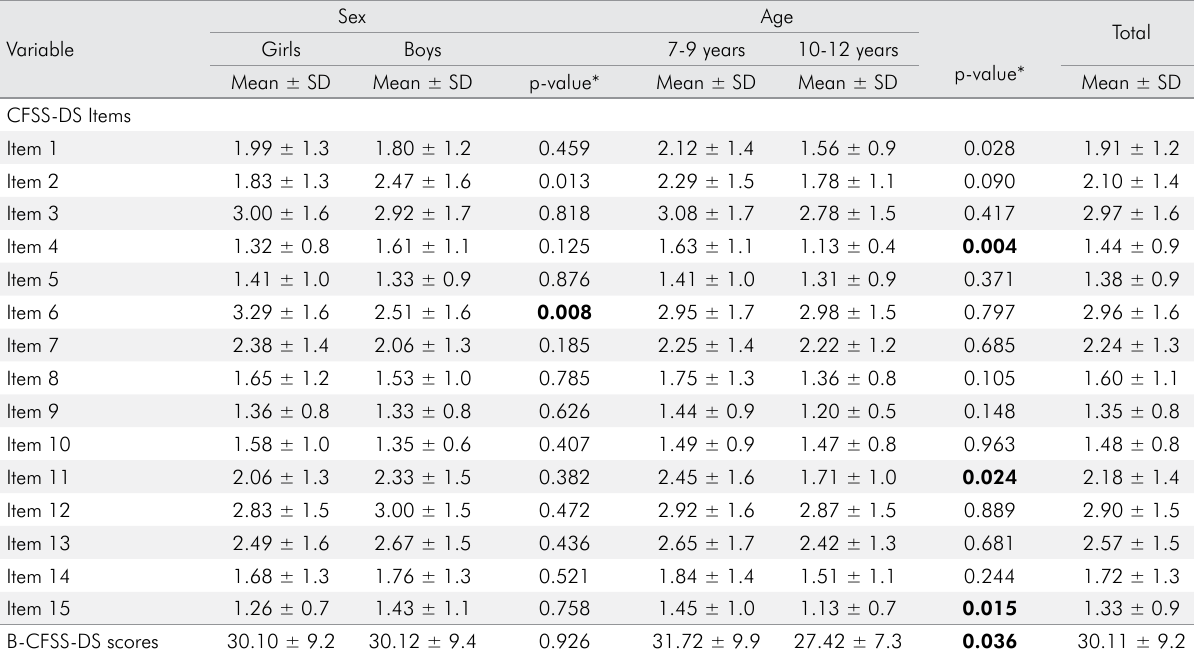
Table 3. Mean and standard deviation of each questionnaire item’s score and total scores of the B-CFFS-DS according to gender and age.